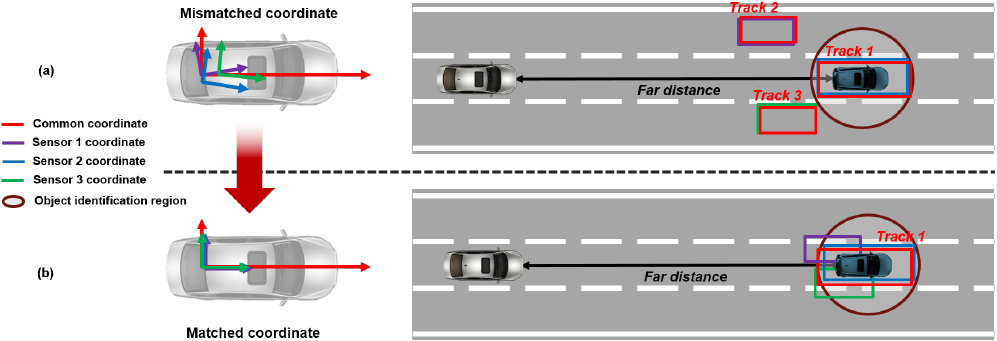
Figure 2. The concept of coordinate correction to solve the object identification problem. ( a ) The object identification problem caused by coordinate mismatching. ( b ) The object identified by coordinate